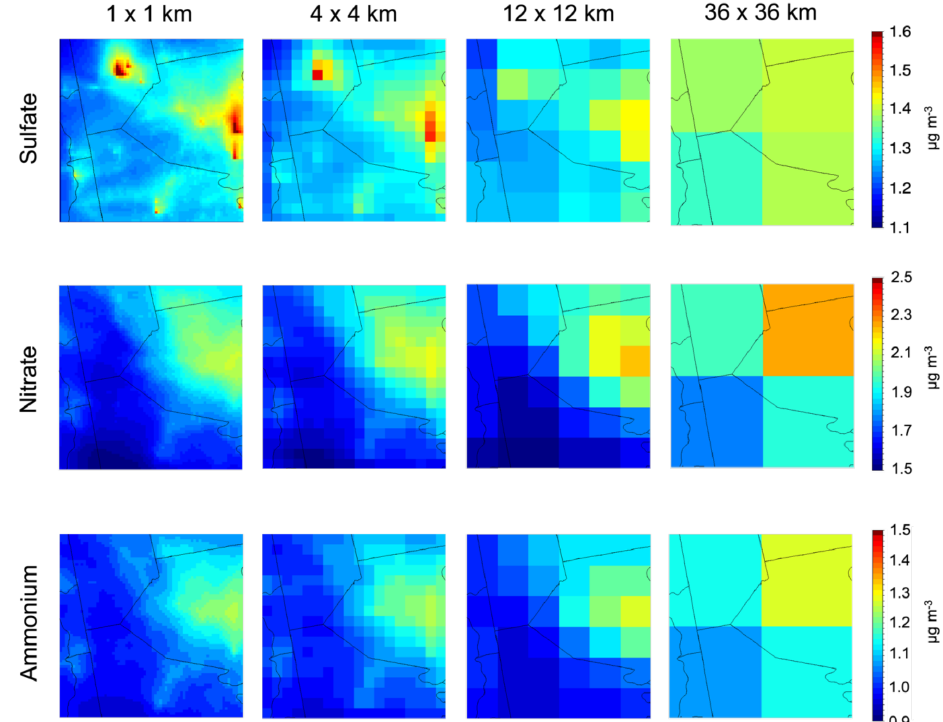
Figure 4. Average predicted ground-level concentration of PM 2 . 5 sulfate, nitrate, and ammonium at a 36 × 36, 12 × 12, 4 × 4, and 1 × 1km resolution during February 2017. Different color scales that do not start from zero are used for the various